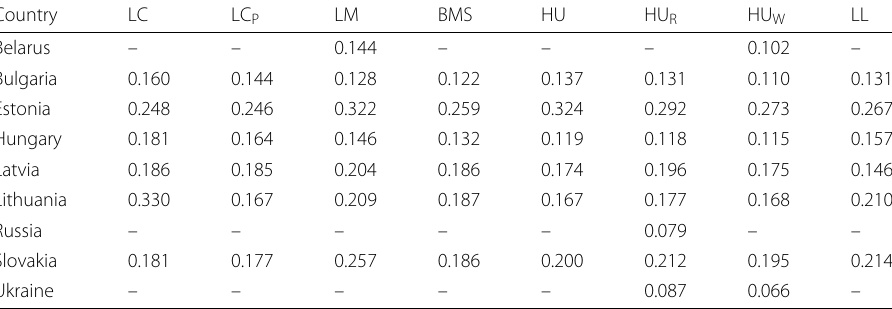
A blank place means the forecast of e 0 was lower than the last observed value of e 0